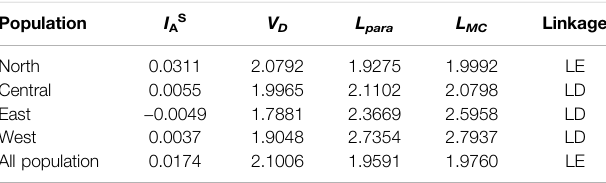
TABLE 3 | Linkage equilibrium analyses in Sudanese population of Theileria annulata . Population